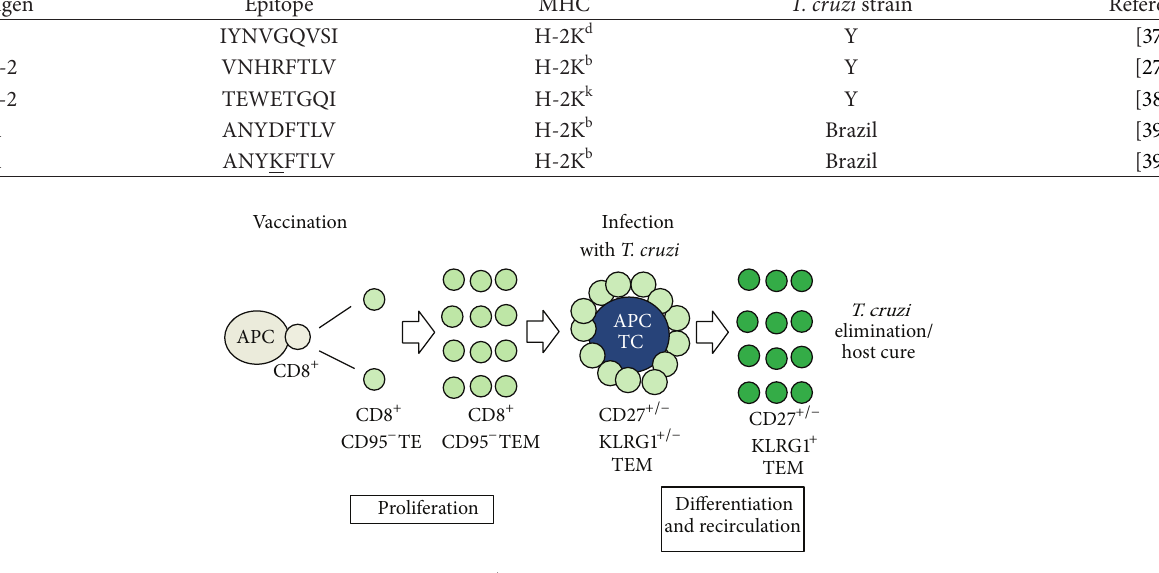
Figure 4: Proposed model for activation of specific CD8 + lymphocytes expanded by genetic vaccination after infection with T. cruzi